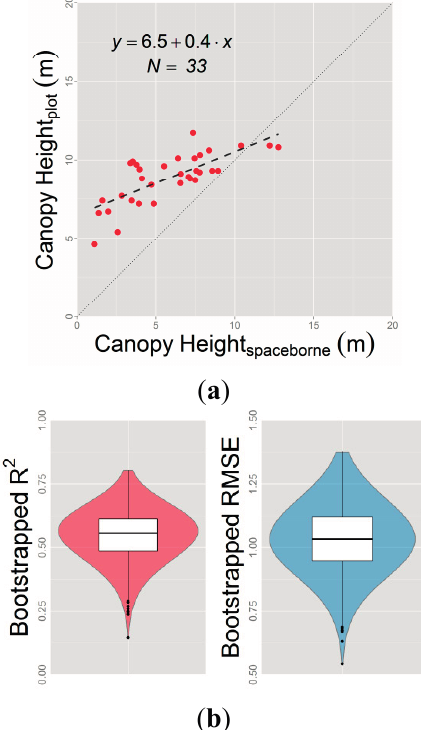
Figure 4. ( a ) The plot showing the linear model for predicting plot-scale maximum canopy height from spaceborne canopy height. The 1-to-1 line (dotted) is shown for reference; ( b ) the distributions of the bootstrapped R 2 and RMSE for the canopy height linear model in (a).